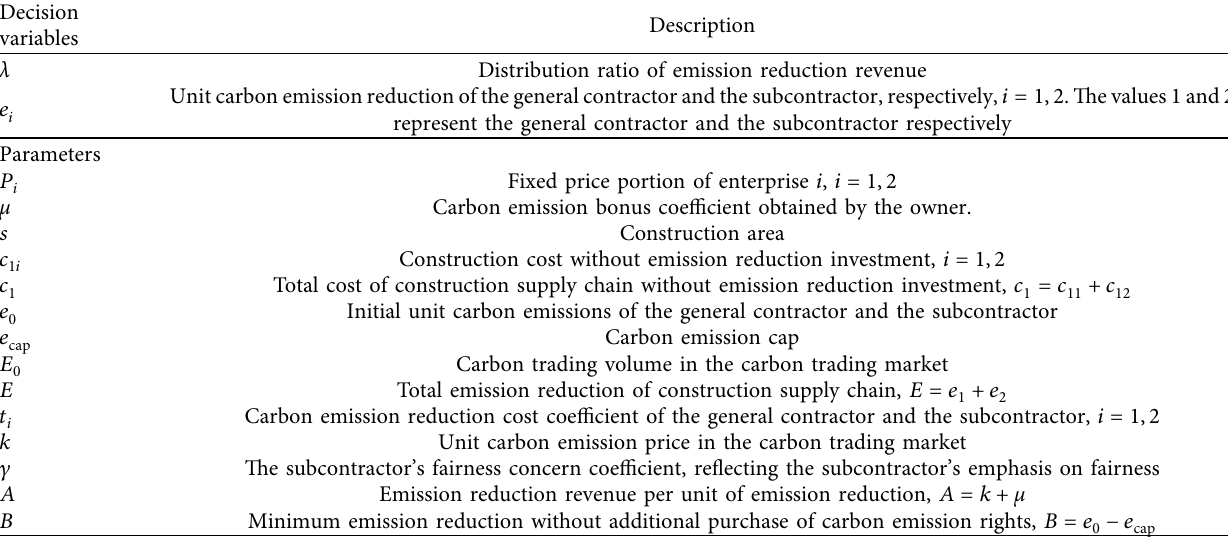
Table 2: Notation of parameters and